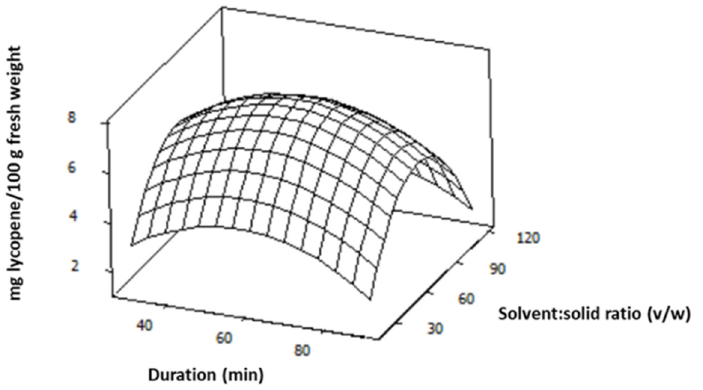
Figure 2. Surface plot for lycopene content (mg/100 g fresh weight) affected by duration of extraction (min) and solvent:solid ratio ( v / w ).